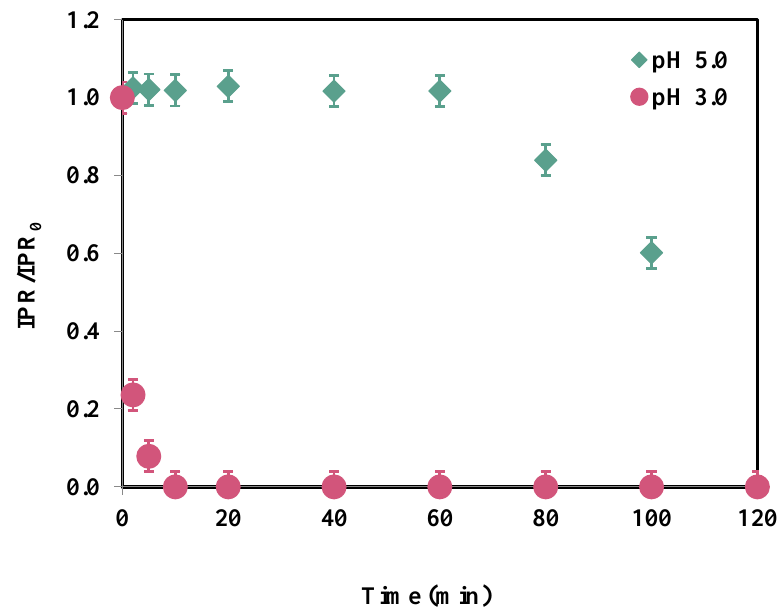
Figure 5. Changes in normalized IPR concentration during ZVI/PS treatments in DW at varying initial pH values. IPR = 2 mg/L; PS = 0.50 mM; ZVI = 1 g/L.